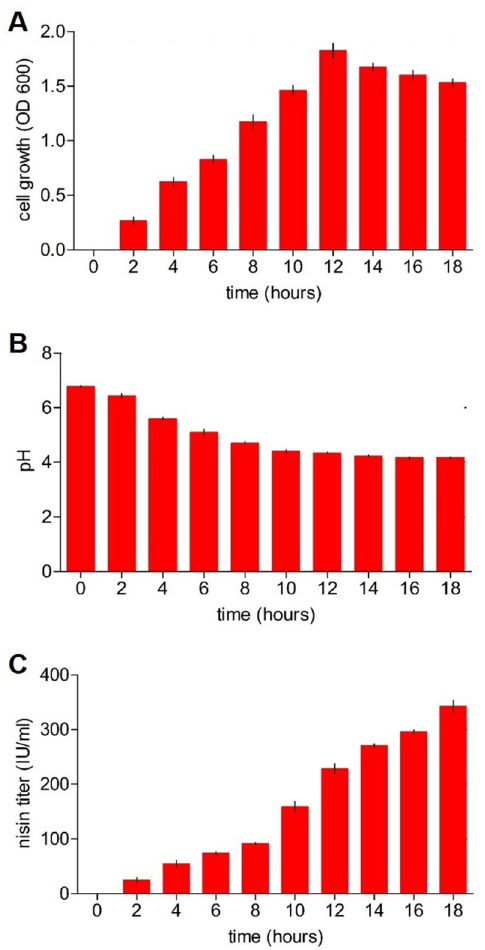
Fig 1. Evaluation of different parameters during the fermentation of the L . lactis subsp. lactis strain wild type. (A) Temporal growth profile. (B) pH of the culture. (C) Nisin A production. The bars represent means of three independent replicates ± standard error (P <